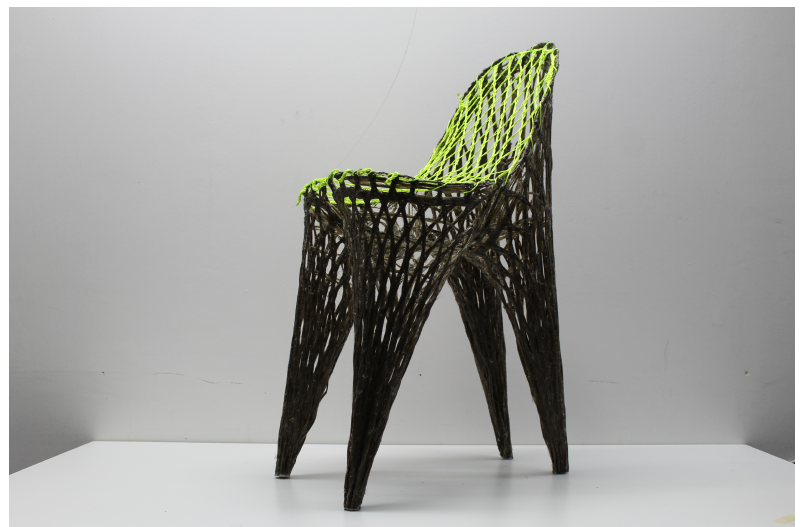
Figure 18. Final Chair Prototype.